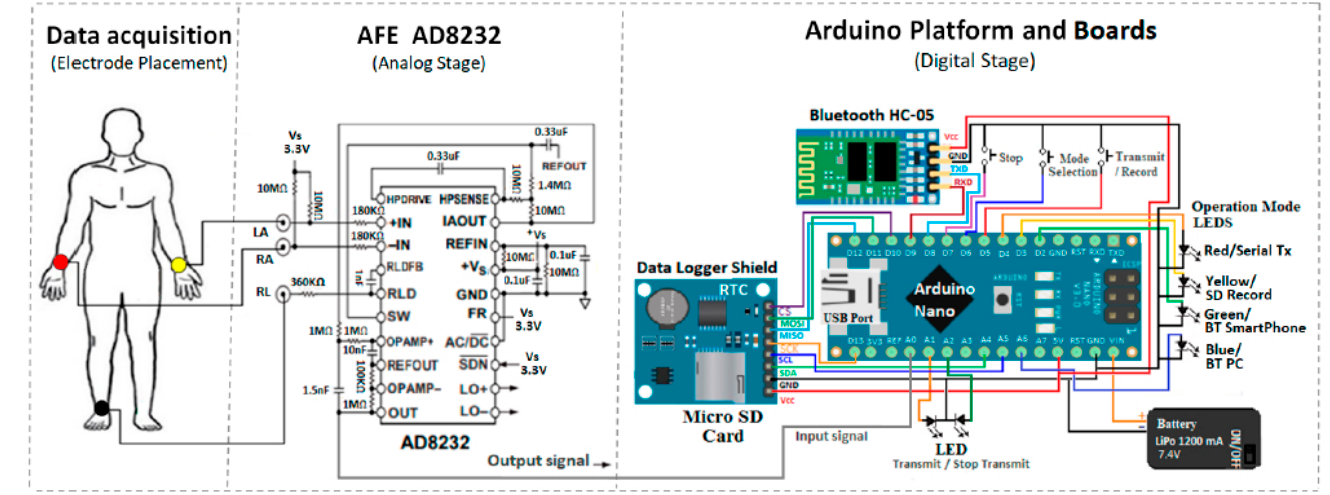
Figure 16. Portable ECG-monitoring device prototype with Arduino Nano and AD8232 AFE [100].